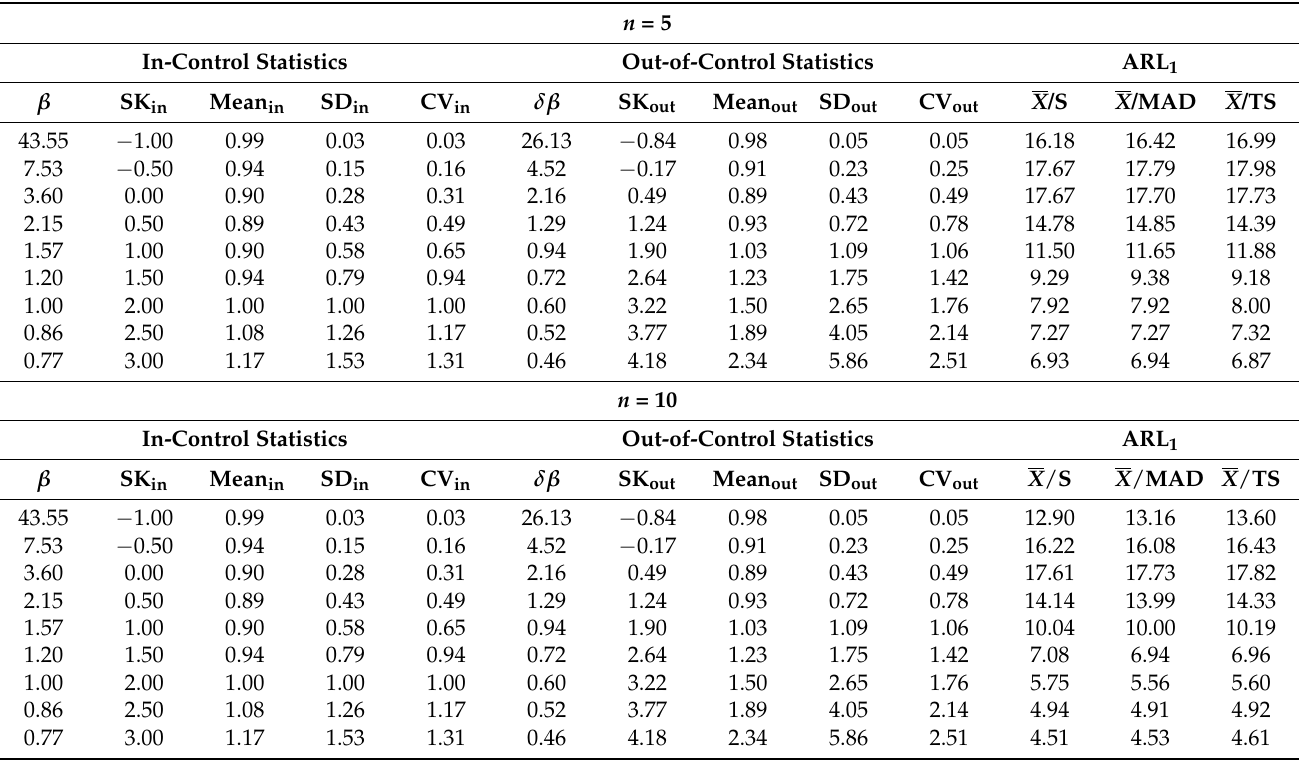
Table 7. ARL 1 values of the WV mean chart for the case δ =